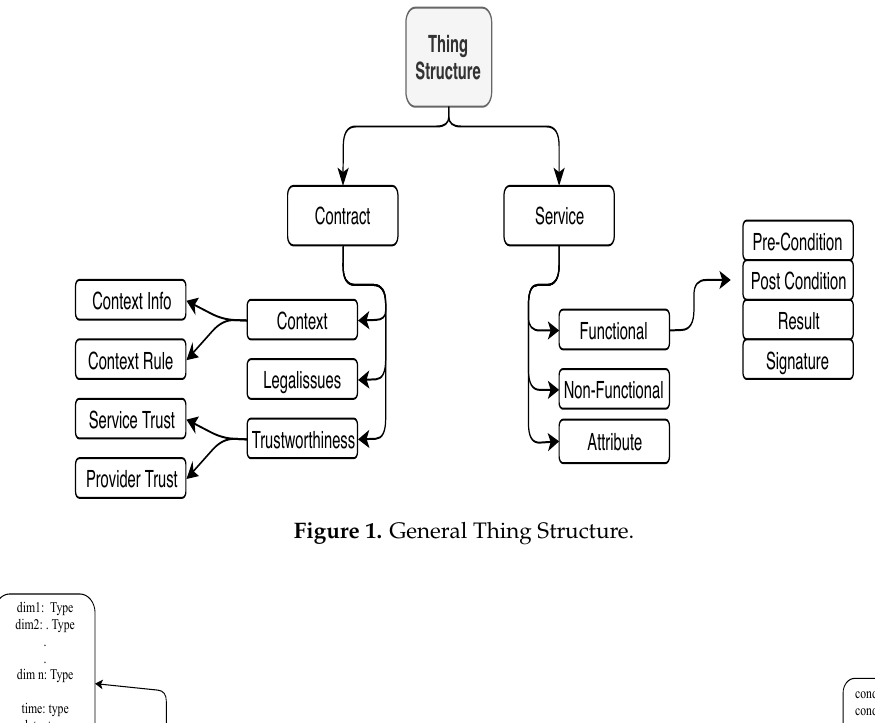
Figure 1. General Thing Structure.